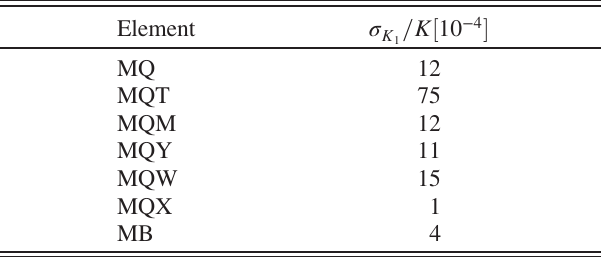
FIG. 4. The probed interval I p for a typical section inside an LHC arc. BPMs are represented by rectangles. The phase advance two consecutive BPMs is approximately 45 °. Used BPMs are shown in orange, unused in gray. Blue diamonds indicate quadrupoles and trim quadrupoles. Only BPMs and quadrupoles are shown, other elements such as corrector spool pieces and the bending dipoles are omitted. TABLE I. Error distribution for the design LHC lattice at 6.5 TeV with weak errors in the final triplet in order to avoid higher order effects. K denotes the main field component (quadrupolar field for quadrupoles, etc.).